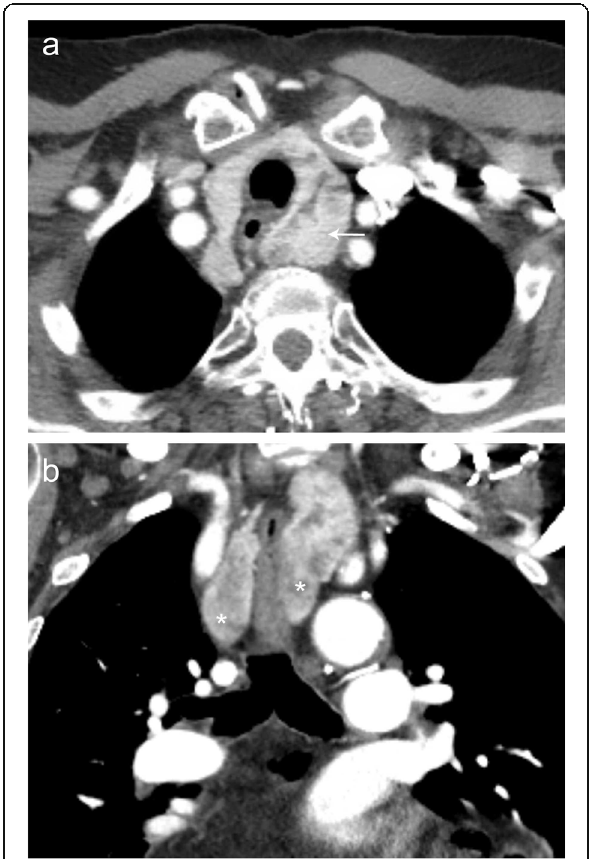
Fig. 26 Multinodular thyroid goiter. Axial ( a ) and coronal ( b ) contrasted CT imaging demonstrates an enlarged heterogeneous multinodular appearance of the thyroid gland. Note that this enlargement is causing rightward deviation of the trachea (arrow) and substernal extension (asterisk) into the anterior mediastinum